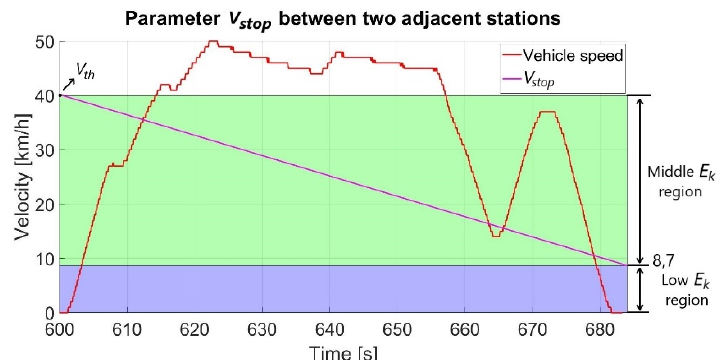
Figure 7. Parameter, V stop , evolution between two stops.